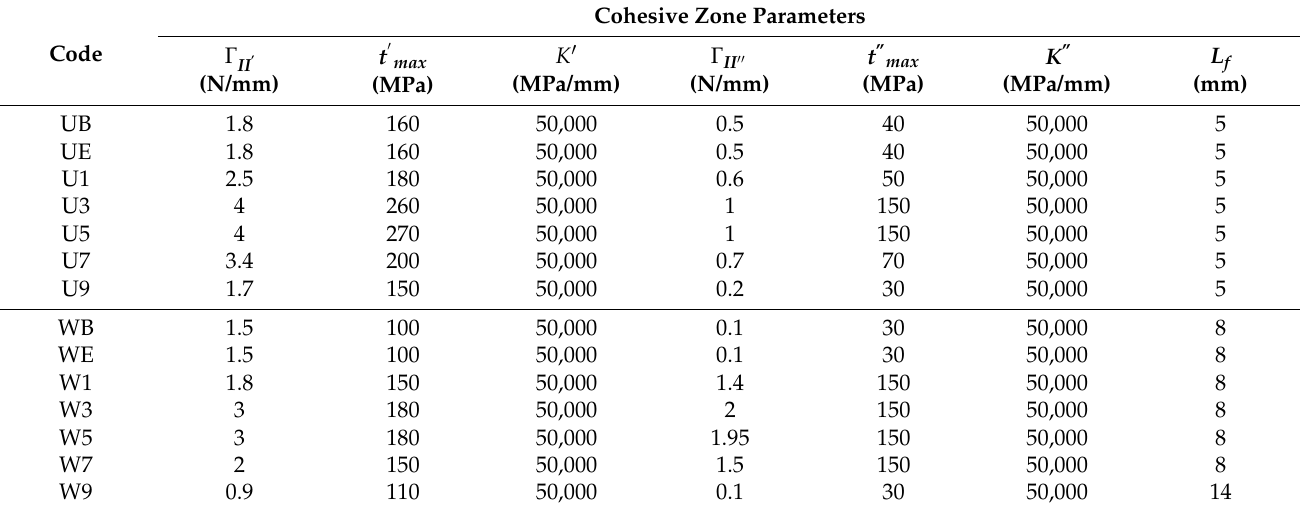
Table 4. Cohesive zone